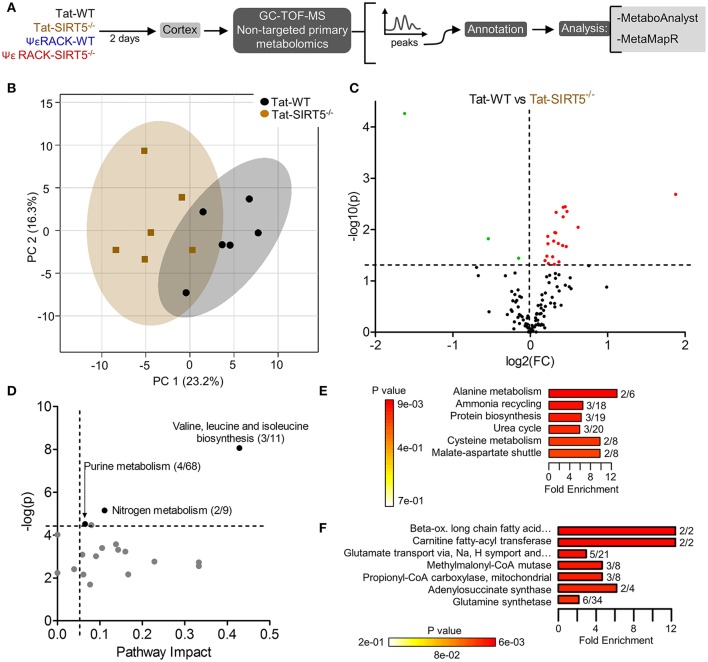
Altered metabolic pathways in SIRT5−/− cortex. (A) Schematic of experimental paradigm. Tat, control peptide; ΨεRACK, PKCε-specific activator (B–F) comparison of WT and SIRT5−/− cortical metabolite profiles in the control condition (n = 6). (B) Scores plot from principal component analysis (PCA) showing clustering of groups based on quantitative variances of annotated metabolites. 95% confidence intervals are displayed for each group. (C) Volcano plot of –log(p-value) and log2(fold-change) values for all annotated metabolites. Dashed lines display significance cutoffs (see text). Green, decrease; Red, increase. (D–F) Pathway and enrichment analysis for significantly altered metabolites in SIRT5−/− cortex. (D) Higher pathway impact value indicates greater centrality or importance in that particular pathway. Dashed lines display significance cutoffs (see text). (E) Enrichment analysis for metabolite sets based on normal metabolic function. Fold enrichment values indicate whether metabolites appear more than expected by random chance (see text for significance cutoffs). (F) Same as in E but for metabolite sets predicted to be altered in the case of dysfunctional enzymes.